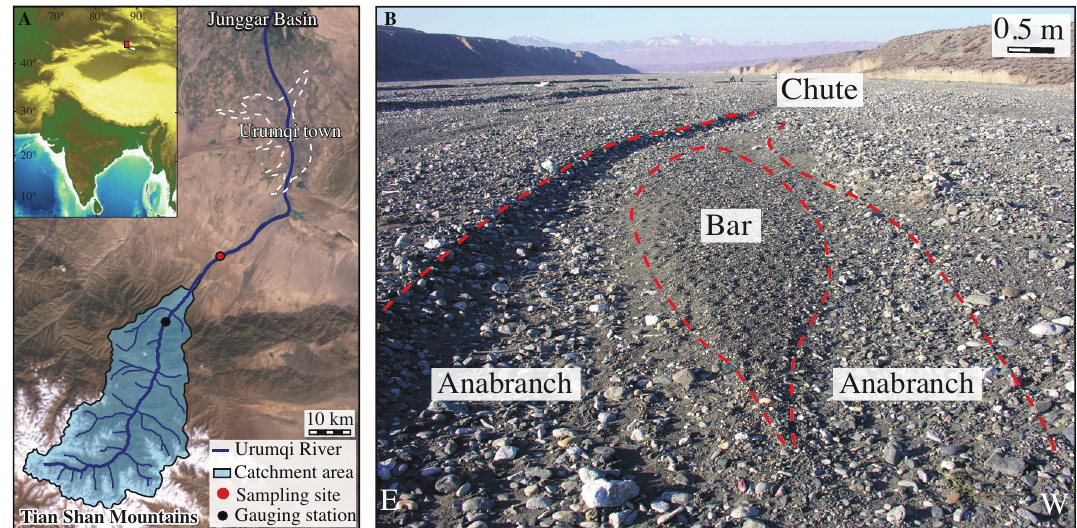
Fig. 2. (a) Location of the sampling site (red dot) along the Urumqi River, and (b) example of the three unitary morpho-sedimentary elements of the river bed. Flow is from South to